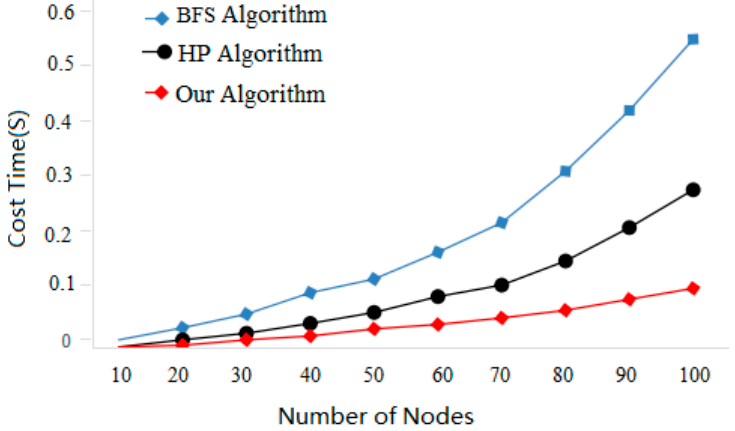
Figure 13. Computational time to determine the optimal routing of dual optimal BDLNs.